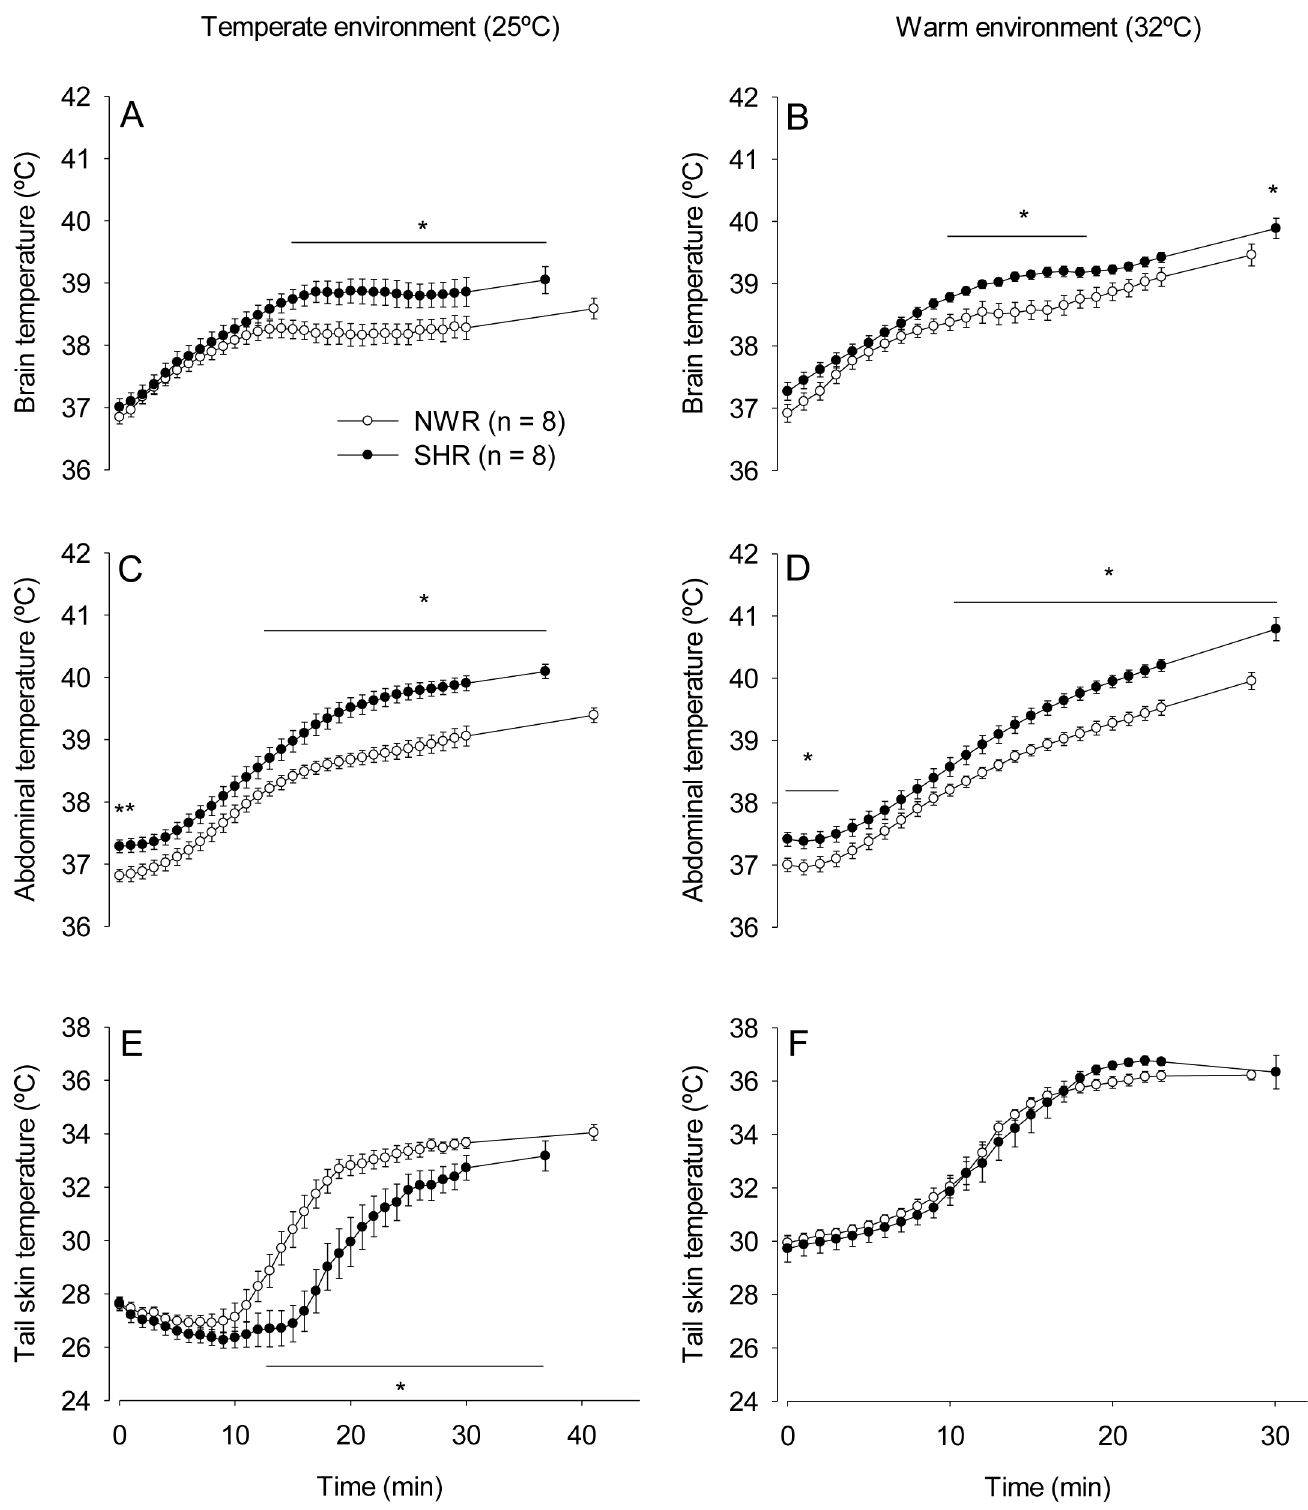
Fig 2. Thermoregulatory responses during incremental exercise. Brain (panels A and B), abdominal (panels C and D) and tail skin (panels D and E) temperatures of SHRs and NWRs subjected to incremental exercise in temperate (panels A, C and E) or warm (panels B, D and F) environments. Data are expressed as the mean ± S.E.M. * p < 0.05 compared with the NWR group in the same environment.